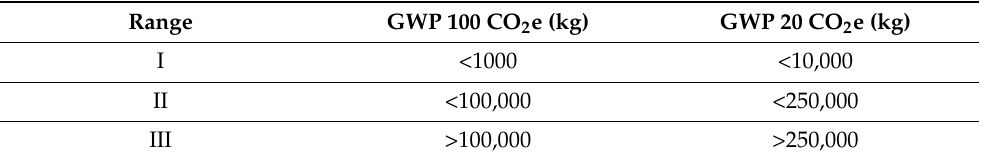
Table 6. Ranges used for presenting the values of CO 2 equivalent released to the atmosphere for GWP 100 and GWP 20.